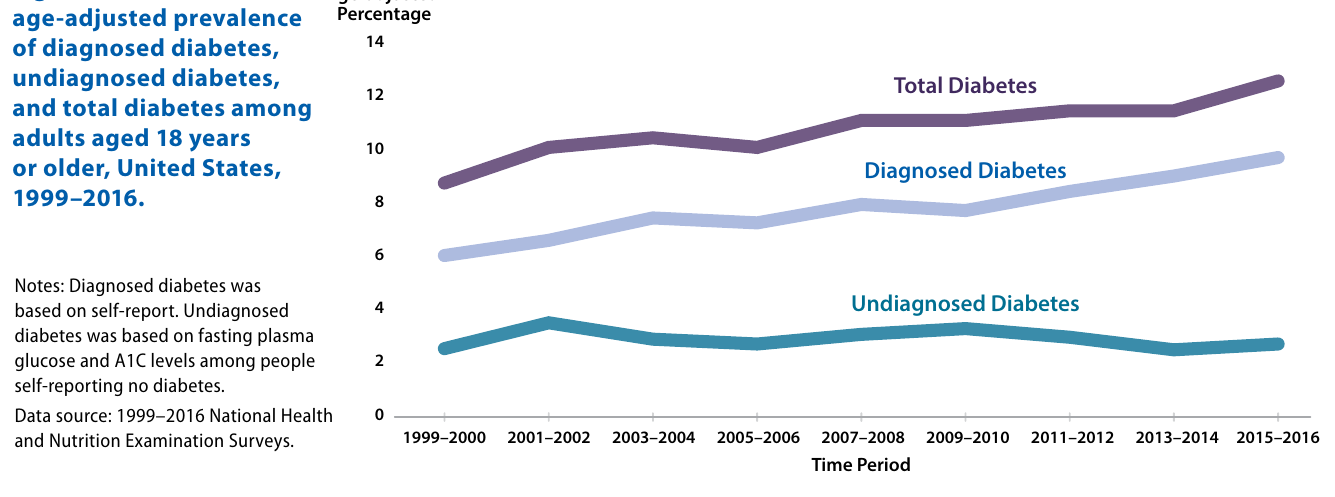
Figure 1. Trends in age-adjusted prevalence of diagnosed diabetes, undiagnosed diabetes, and total diabetes